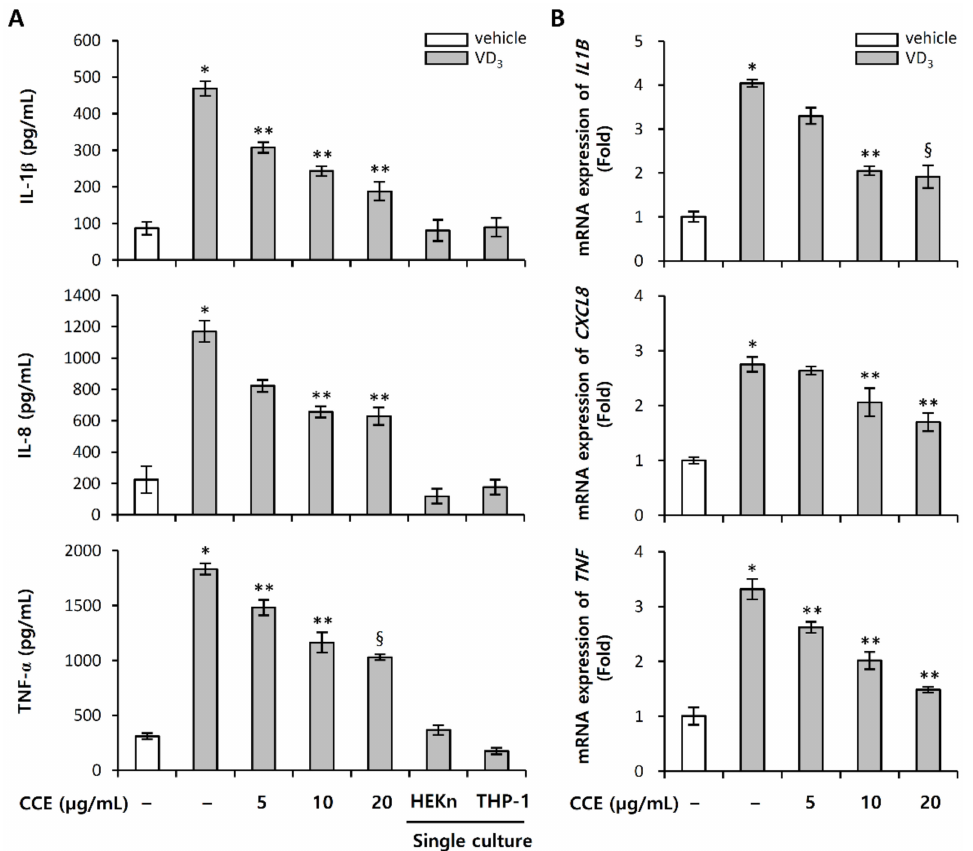
Figure 5. CCE inhibits the expression of pro-inflammatory cytokines induced by VD 3 in HEKn / THP-1 co-culture system. HEKn (passage 3) was seeded in upper insert chambers, and THP-1 was seeded in lower chamber of two-compartment transwell system separately for 24 h. Upper insert chamber was pretreated with 5, 10, or 20 µ g / mL CCE for 1 h, and subsequently treated with 200 nM VD 3 . ( A ) After 72 h incubation, secreted pro-inflammatory cytokines (IL-1 β , IL-8, TNF- α ) were determined by ELISA. Pro-inflammatory cytokines (IL-1 β , IL-8, TNF- α ) mRNA were measured by quantitative real-time PCR. ( B ) mRNA expression was normalized as the relative expression of GAPDH mRNA, and all data are presented as fold induction against control. The results are mean ± standard deviation (SD) ( n = 3). * p < 0.001 vs. vehicle control; ** p < 0.01 vs. VD 3 -treated control; § p < 0.05 vs. VD 3 -treated control; DMSO vehicle control